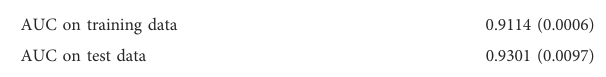
TABLE 2 AUC of DeepBind on Myc (Hassanzadeh and Wang, 2016) on Training and Test datasets.